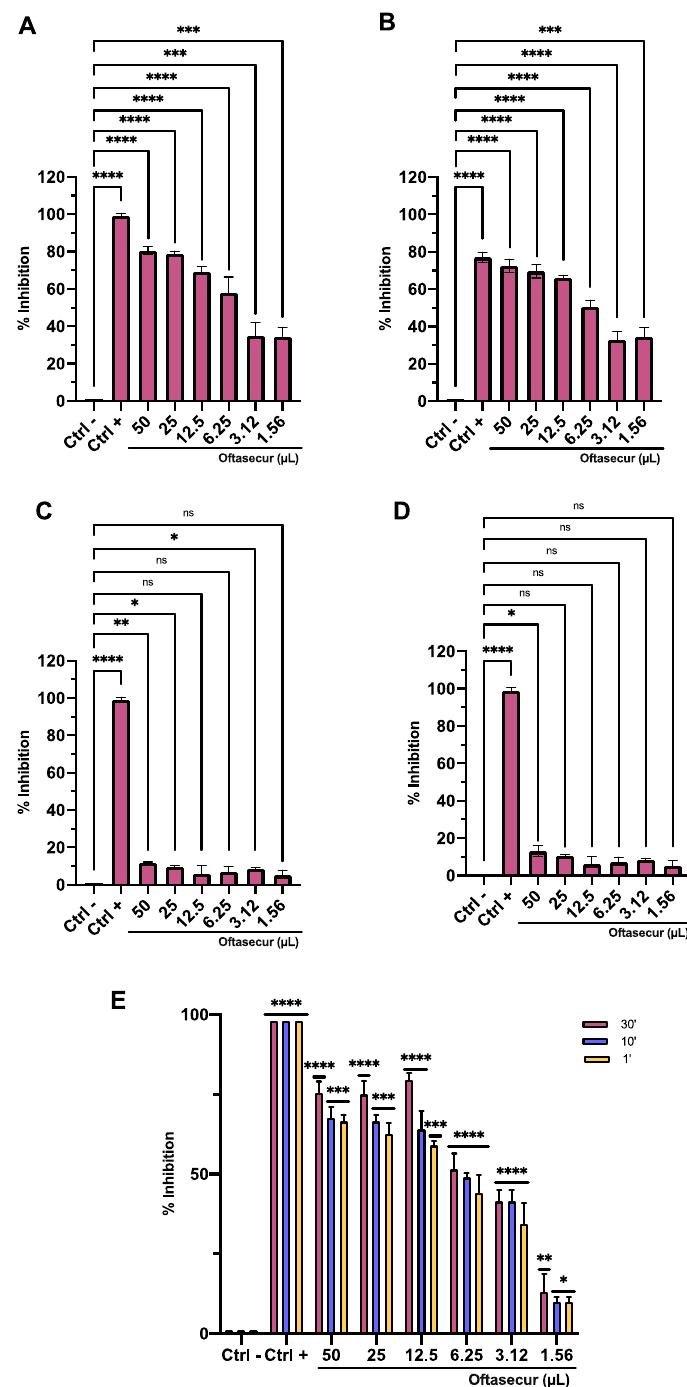
Figure 6. Antiviral activity of Oftasecur against HSV-1 in four plaque reduction assays: ( A ) co-treatment assay (****: p -value < 0.0001, ***: p -value = 0.0004); ( B ) pre-virus assay (****: p -value < 0.0001) ; ( C ) cell pretreatment assay (****: p -value < 0.0001, **: p -value = 0.0063, *: p -value = 0.0208, ns: p -value > 0.1044) ; ( D ) post-treatment assay (****: p -value < 0.0001, *: p -value = 0.0187, ns: p -value > 0.0600). ( E ) Pre-virus assay after 30, 10, and 1 min of exposure (****: p -value < 0.0001, ***: p -value = 0.0002, **: p -value = 0.0073; *: p -value = 0.039) .